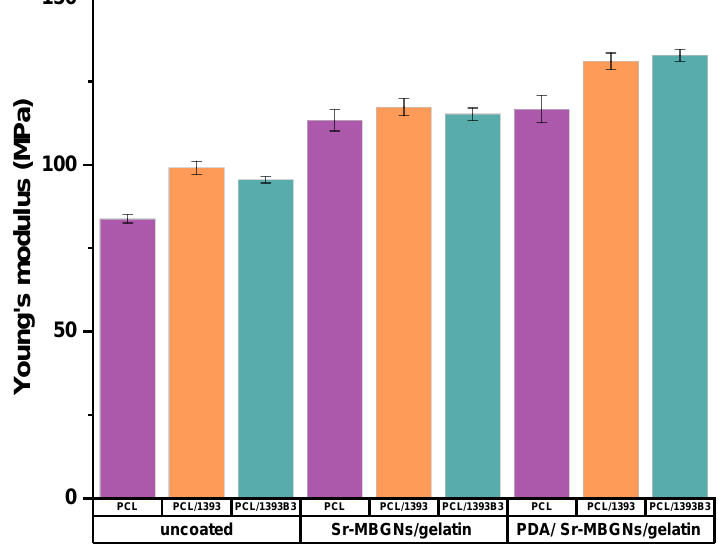
Figure 4. Young’s modulus of scaffolds. The data are represented as mean ± standard deviation (SD: n = 3).